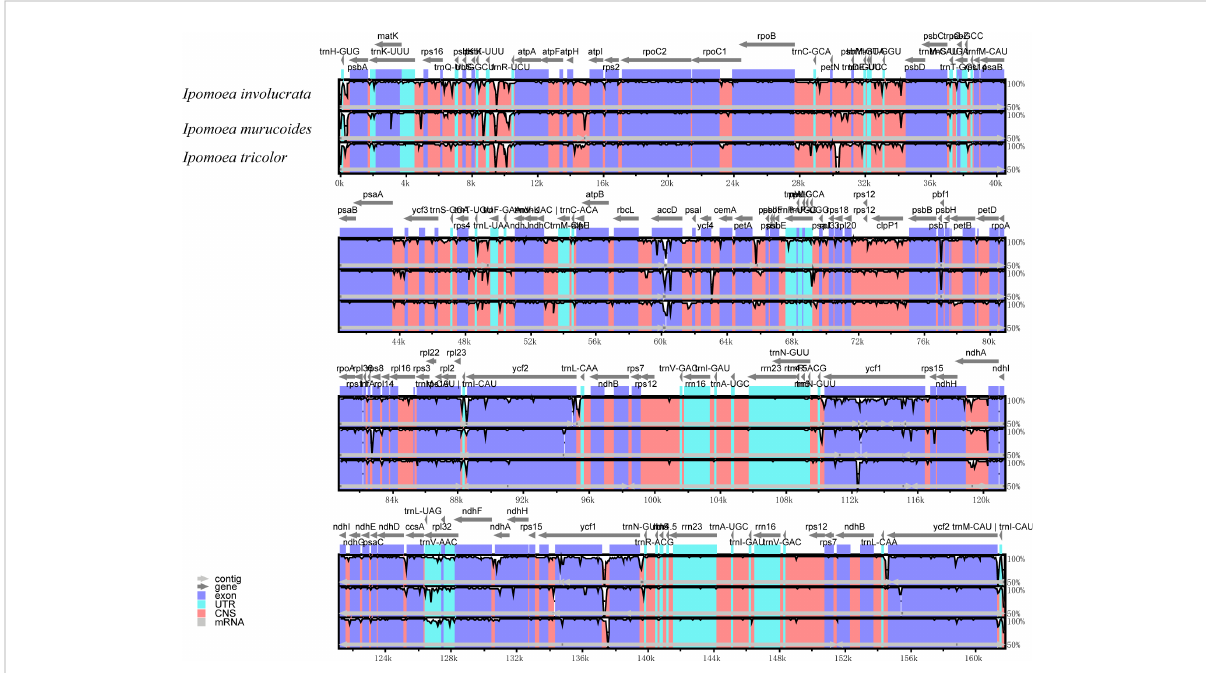
FIGURE 7 The sequence diversity of the chloroplast genomes of three Ipomoea species. The sequence identity plot shows the diversity along the chloroplast genome of I. involucrate , I. murucoides , and I. tricolor with I. pes-caprae as a reference using mVISTA. Gray arrows and thick black lines above the alignment indicate genes with their orientation and the position of the IRs, respectively. The colors indicate the exon, UTR, and conserved non-coding sequences (CNS) and mRNA regions. A cutoff of 70% identity was used for the plots, and the Y-scale represents the identity percentage ranging from 50 to 100%.